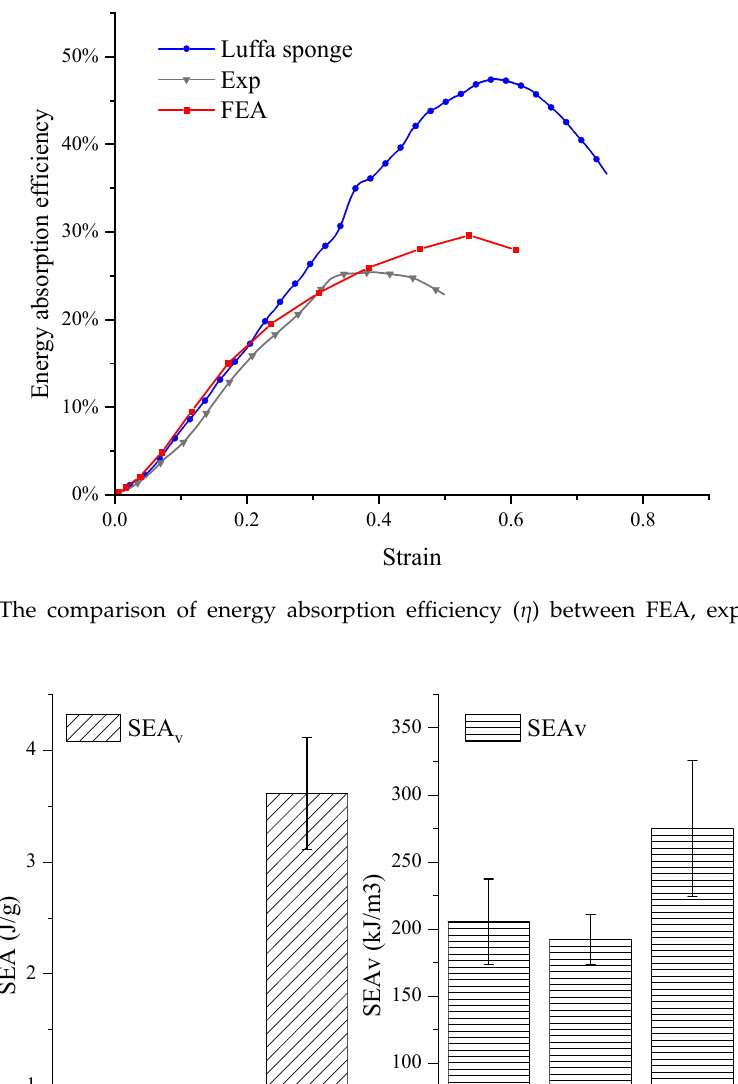
Figure 13. SEA v and SEA between FEA, experiment and lu ff a SEA and SEA between FEA, experiment and luffa sponge. Figure 13. v SEA and SEA between FEA, experiment and luffa sponge. Figure 13. v